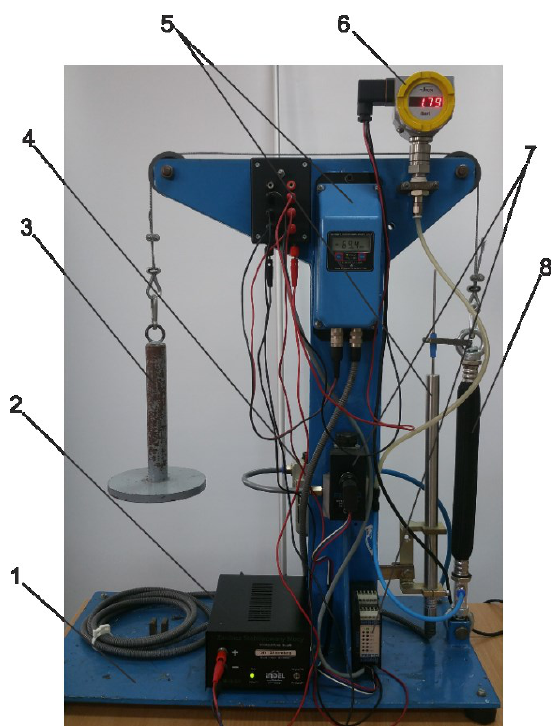
Fig. 4. General view of the test stand: 1 – base, 2 – power supply, 3 – mass load, 4 – FRL (Filter-Regulator-Lubricator) unit, 5 – displacement sensor, 6 – pressure sensor, 7 – proportional pressure valve, 8 – pneumatic artificial